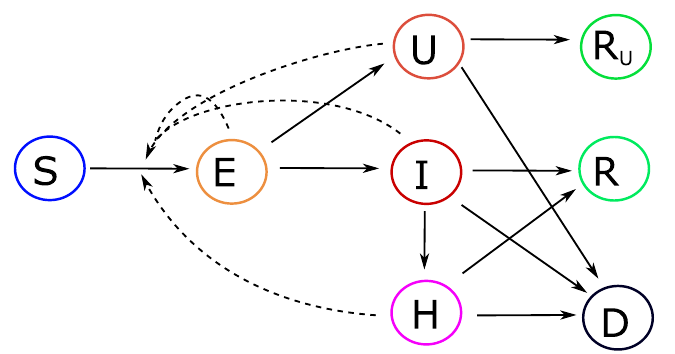
Figure 1. Model structure for the transmission dynamics of an infectious disease, on the example of COVID-19. Solid arrows indicate transition from one compartment to another, dashed arrows indicate virus transmission due to contact with infectives. Upon infection, susceptible ( S ) individuals enter a latent/ presymptomatic phase ( E ). After symptoms onset, infections may be detected ( I ) or remain undetected ( U ). Detected cases might become severe and require hospitalization ( H ). Infected individuals who recovered from a detected ( R ) or an undetected ( R U ) infection, as well as patients who died ( D ) upon infections, are removed from the chain of transmission.